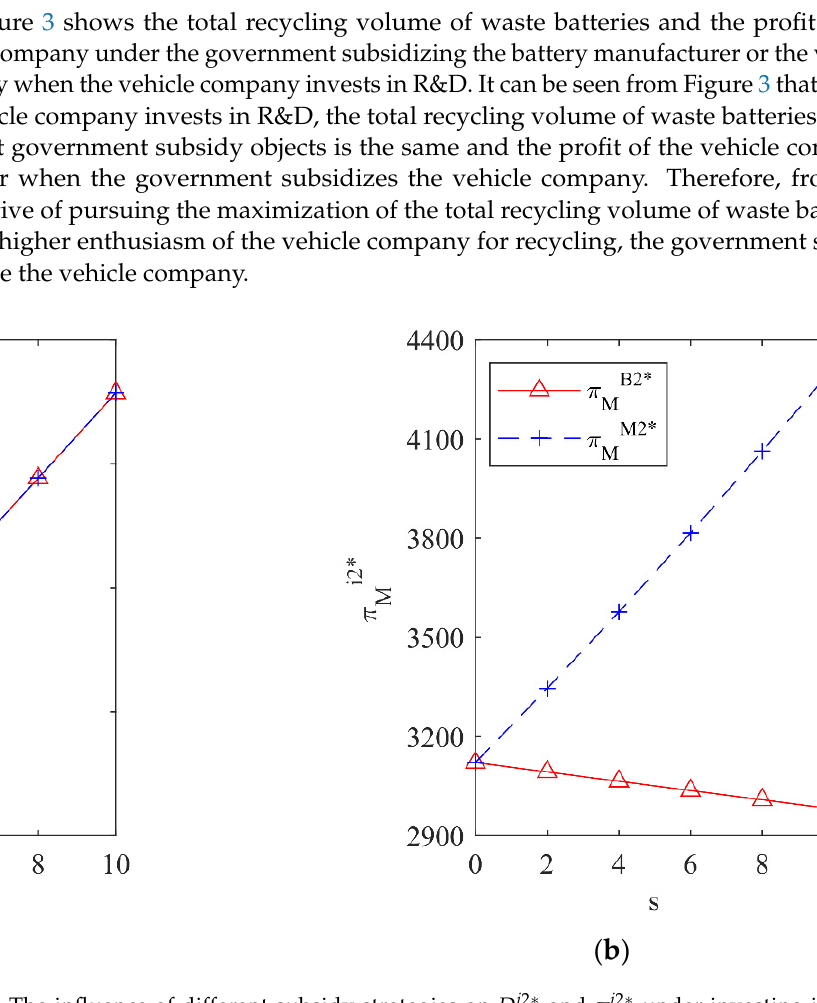
Figure 3. The influence of different subsidy strategies on D i 2 ∗ and π i 2 ∗ ( a ) The total recycling volume; ( b ) The profit of the vehicle company.